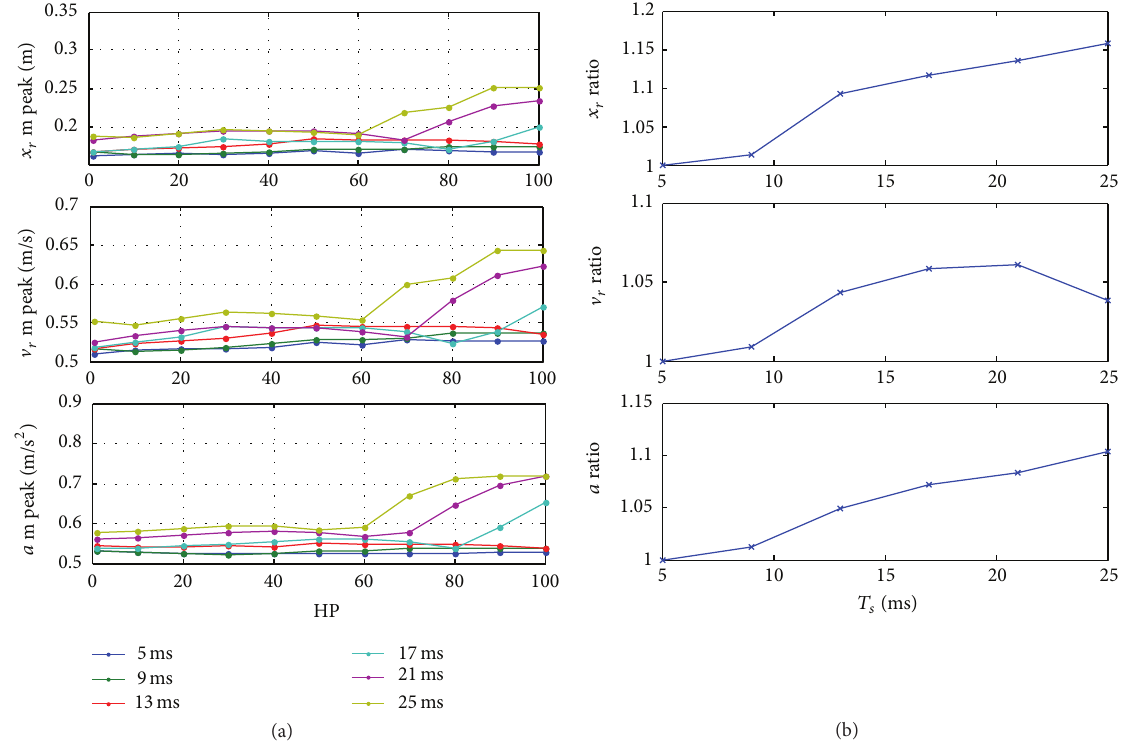
Figure 6: (a) SDOF system’s mean peak responses ( 𝑓 𝑛 = 0.25 Hz and 𝜉 = 10 % for SAMPCVD with HC = 1 and 𝑟 = 1 ) evolutions with control interval 𝑇 𝑠 and prediction horizon HP, when subjected to type 1 seismic actions (10 accelerograms). (b) Ratios evolution with control interval (relative to 𝑇 𝑠 = 5 ms) for HP = 50